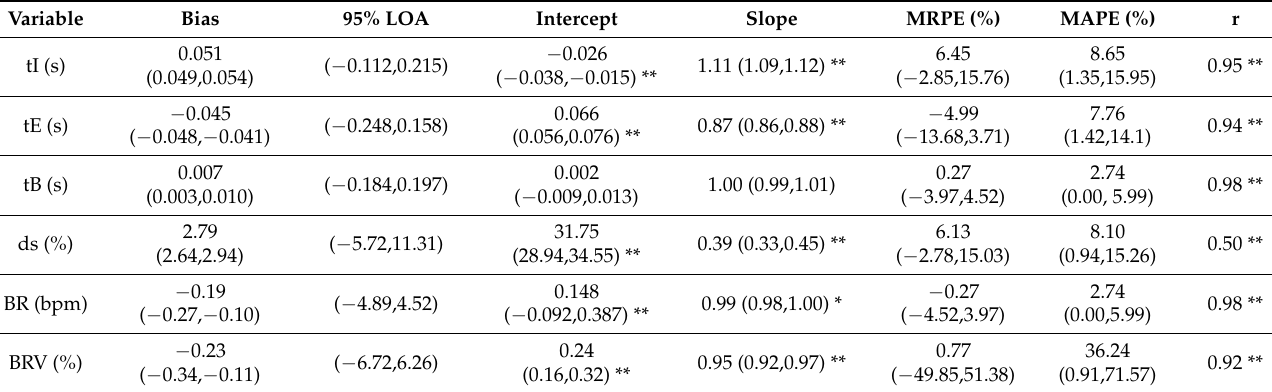
Figure 8. Passing–Bablok regression plots of all BP comparisons. CI: 95% confidence interval. Table 4. Method comparison results.